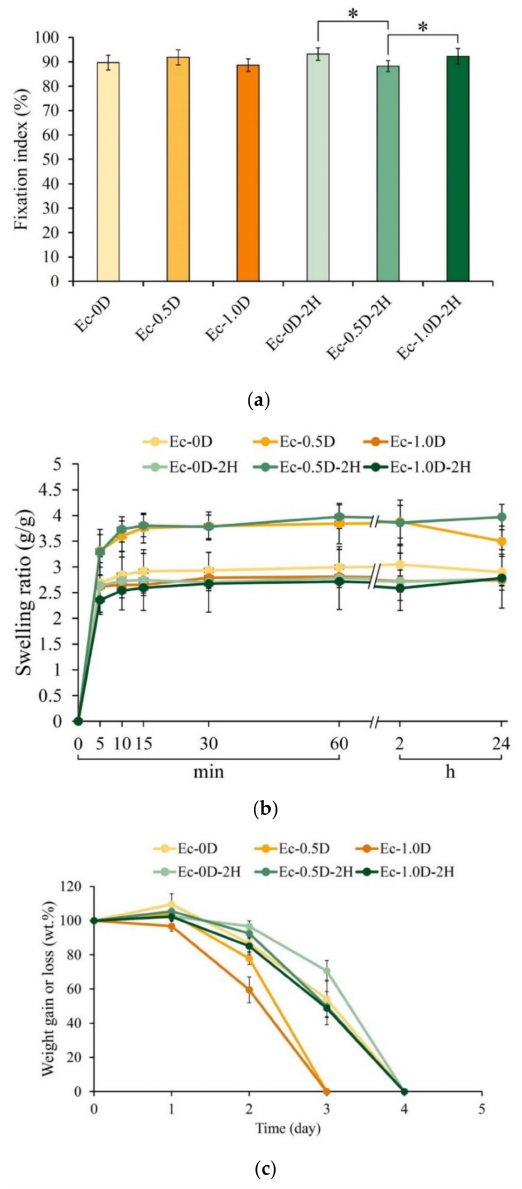
Figure 6. Fixation index (%) reflecting the degree of crosslinking of Ec-0D, Ec-0.5D, Ec-1.0D, Ec-0D- 2H, Ec-0.5D-2H, and Ec-1.0D-2H ( n = 3, the symbol * indicates that each group shows p < 0.05) ( a ). Swelling rates of different hydrogel membranes after 24 h of soaking ( n = 10) ( b ) and weight changes in different hydrogel membranes during immersion in PBS ( n = 6) ( c